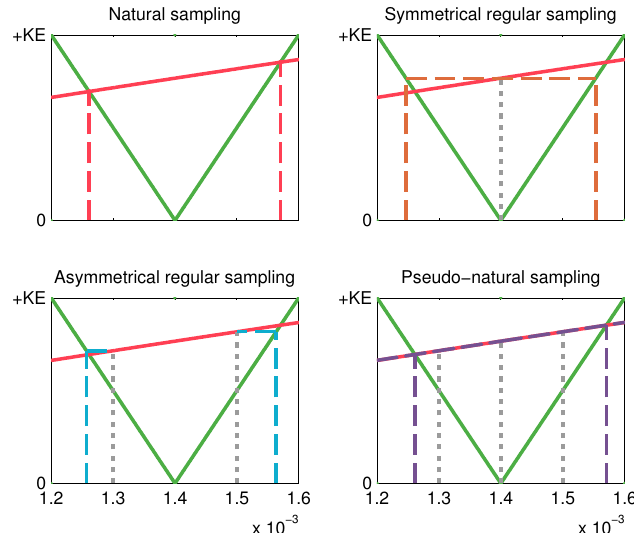
Figure 5. Switching interval and switching instants yield by four sampling techniques corresponds with the square shown in Table 2 for case (a). Table 2. Comparison of sampling methods in the time and frequency domains with E = 50